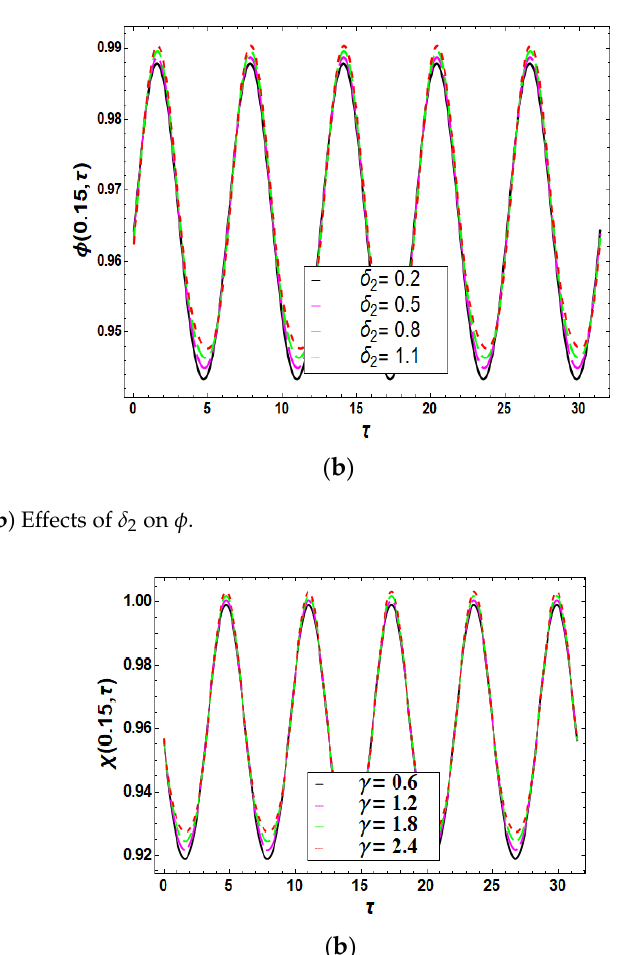
f ξ for various values of